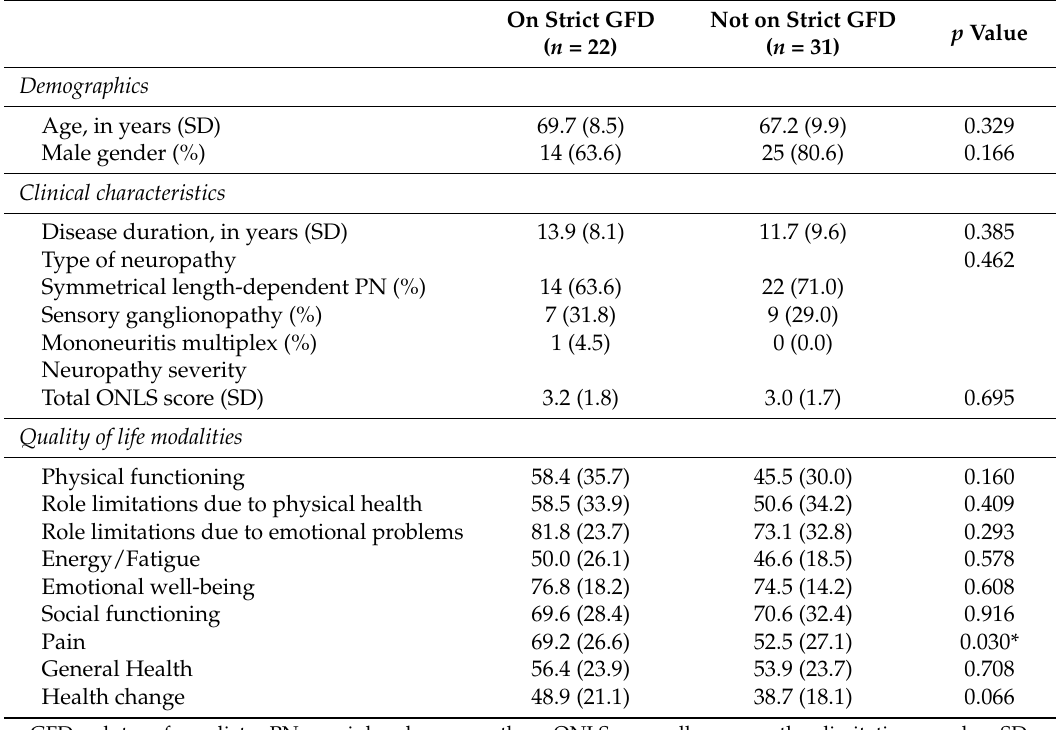
Table 3. Demographic, clinical, and quality-of-life-related characteristics of patients with gluten neuropathy being on a strict gluten-free diet versus patients not being on a strict gluten-free diet (serologically confirmed by the elimination of anti-gliadin